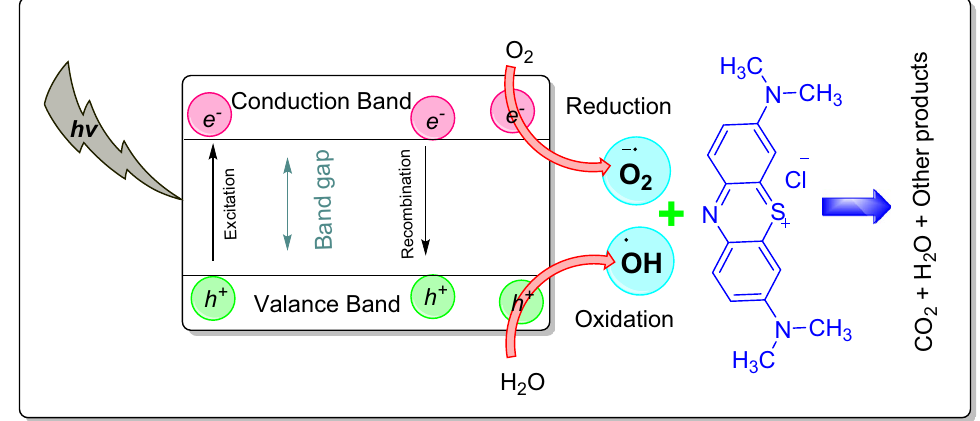
Figure 8. Mechanism of photocatalytic degradation of methylene blue using CuO NS. Image generated using ChemDraw professional